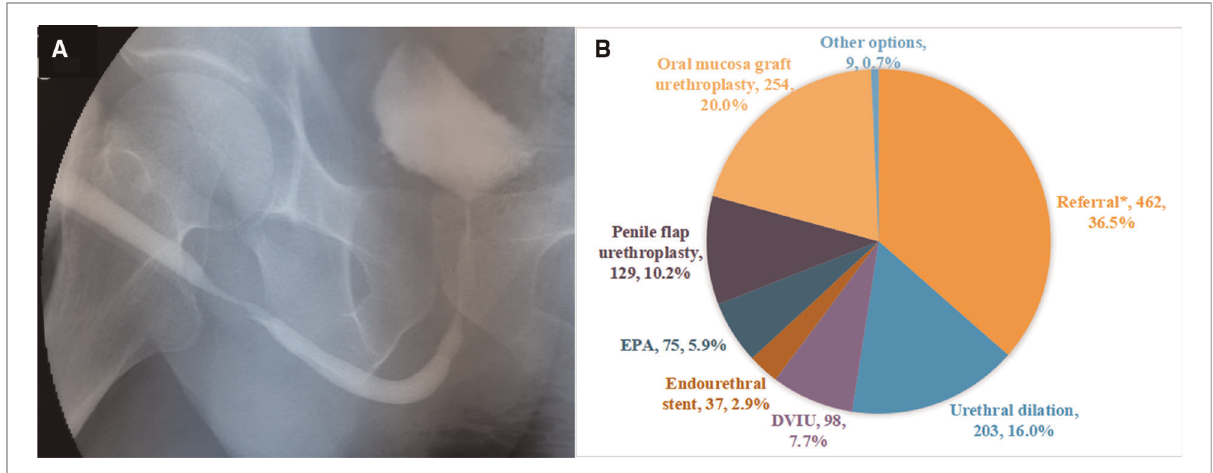
FIGURE 3 ( A ) The urethrography of Case 3. ( B ) Management recommendations of urologists for the Case